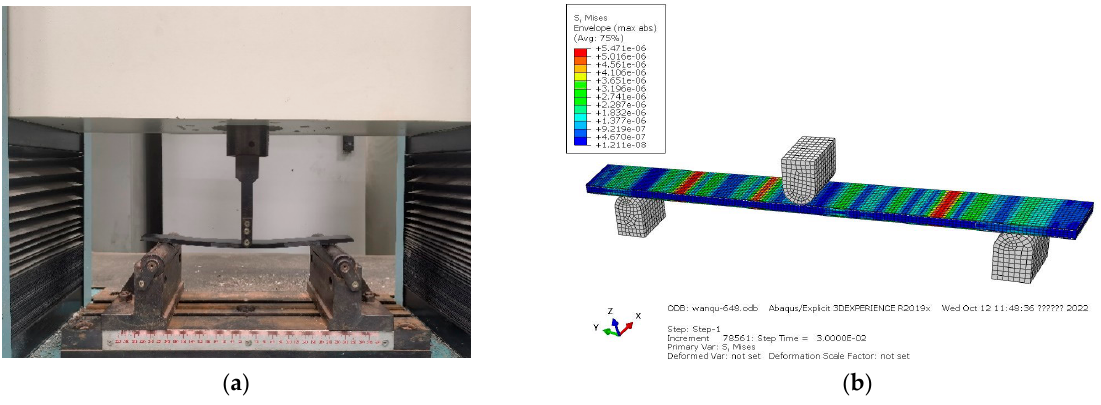
Figure 5. ( a ) Three-point bending experiment and ( b ) FEA model. The load and displacement curve after linear fitting is shown in Figure 6.